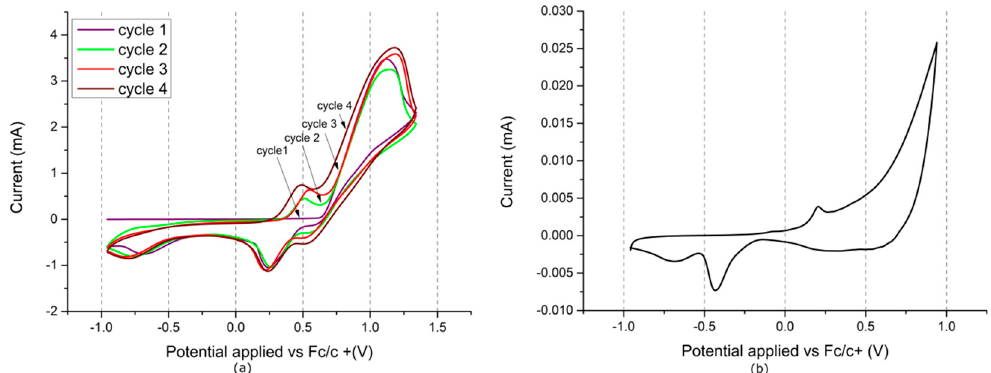
Figure 3. Electrochemical polymerisation of carbazole ( a ), CV of the deposited layer ( b ).